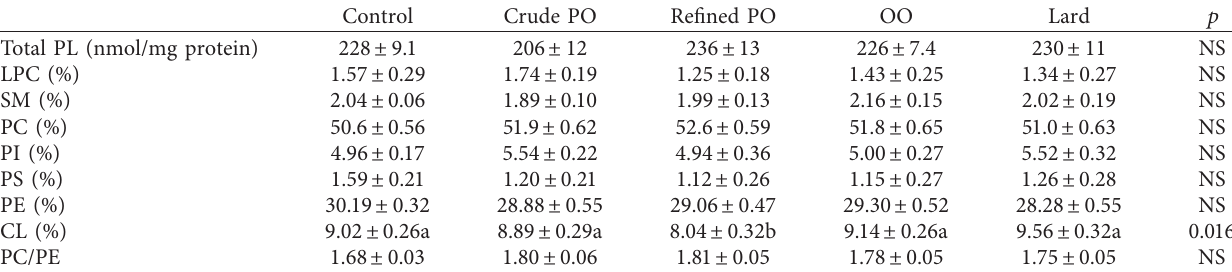
Table 3: Effect of diets on liver mitochondrial membrane phospholipid (PL) composition. Control Crude PO Refined PO